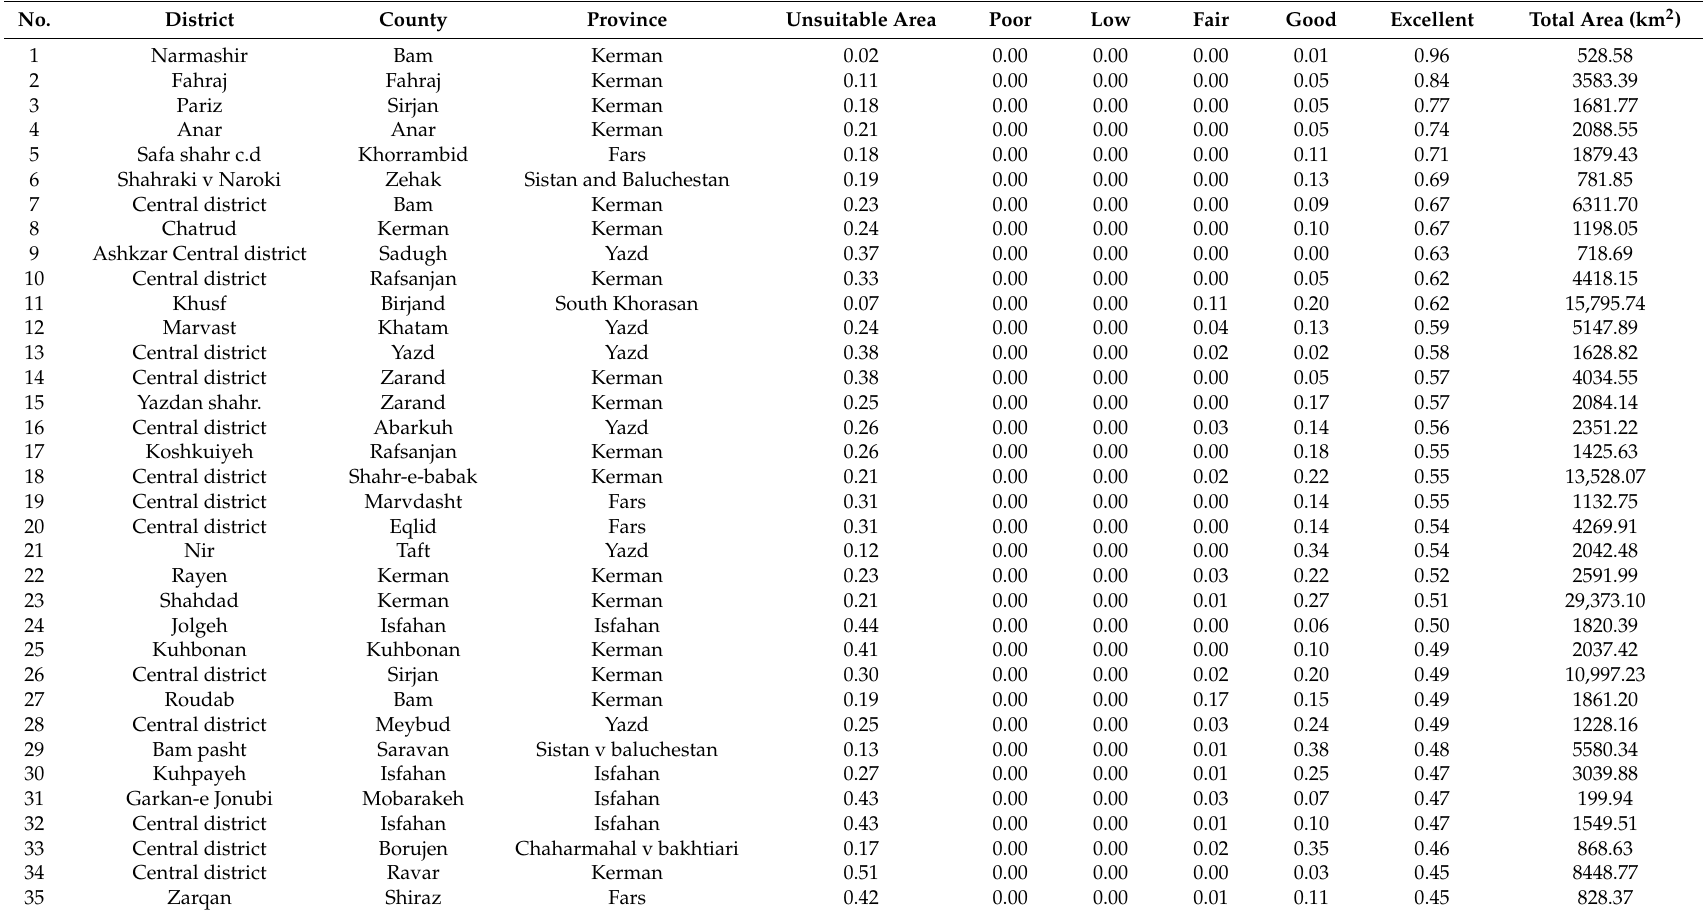
Table A1. The specification of the best 50 districts for exploitation of solar energy in